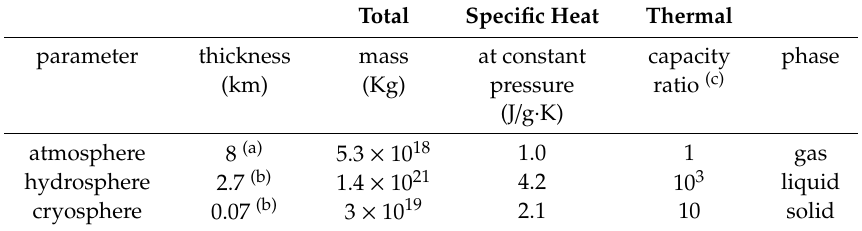
Table 2. The principal parameters of a few components of the Earth. Total Specific Heat